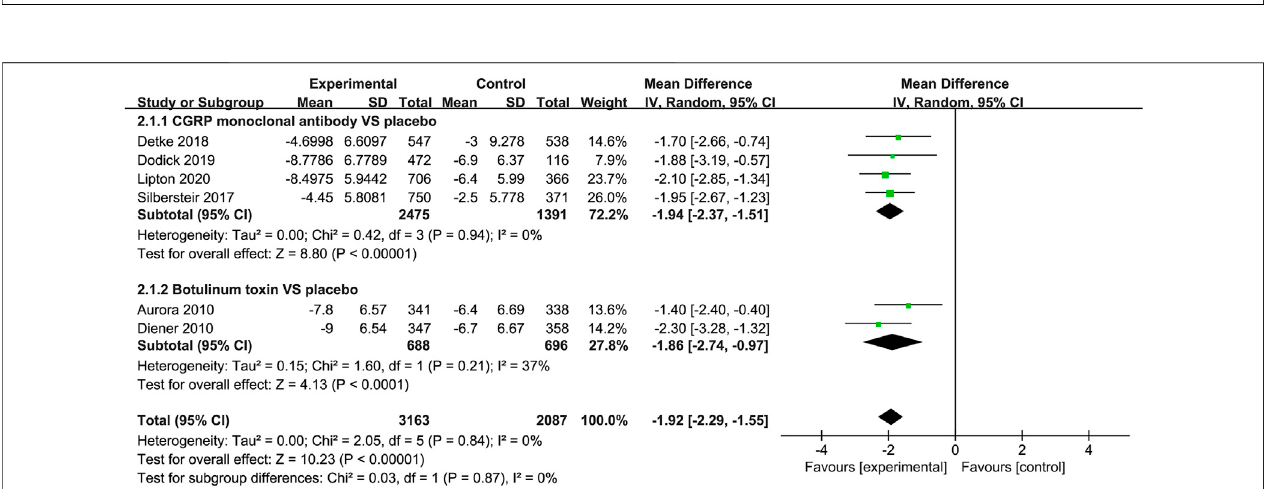
FIGURE 4 | Pooled weighted mean differences of change in headache days in the treatment group compared with placebo; diamond indicates the estimated relative risk with 95% con fi dence interval for the pooled patients.